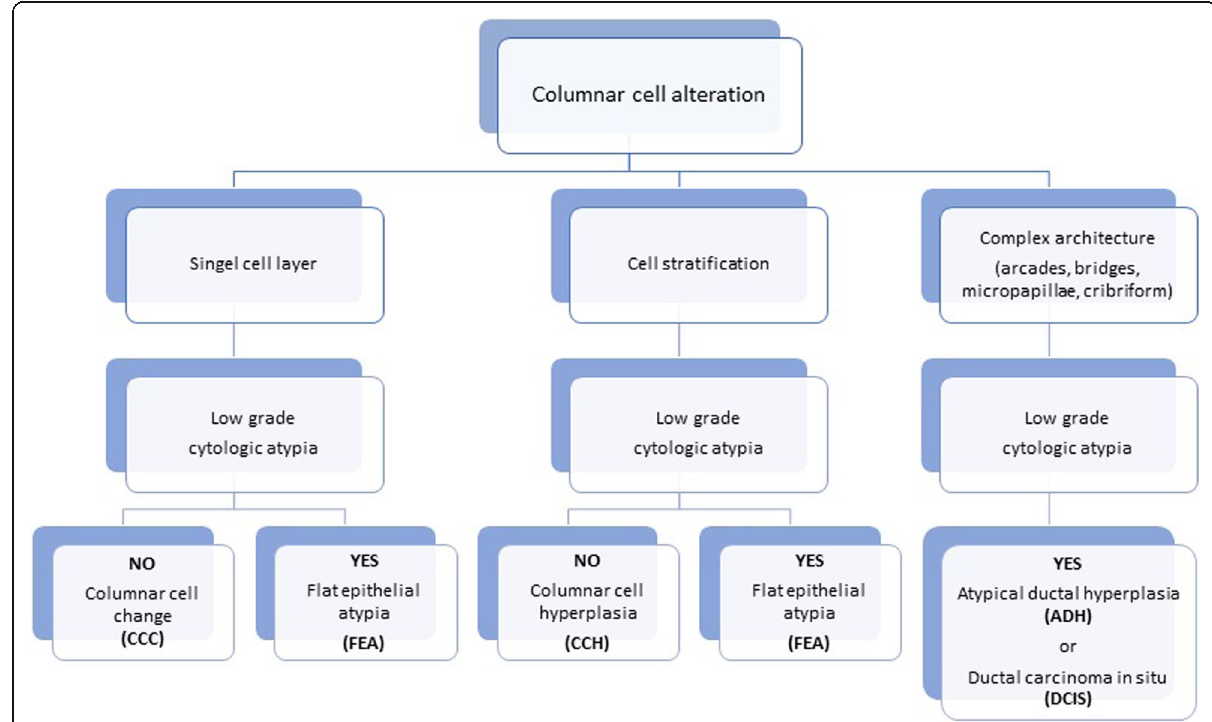
Fig. 7 Algorithmic approach to the diagnosis of columnar cell lesions and flat epithelial